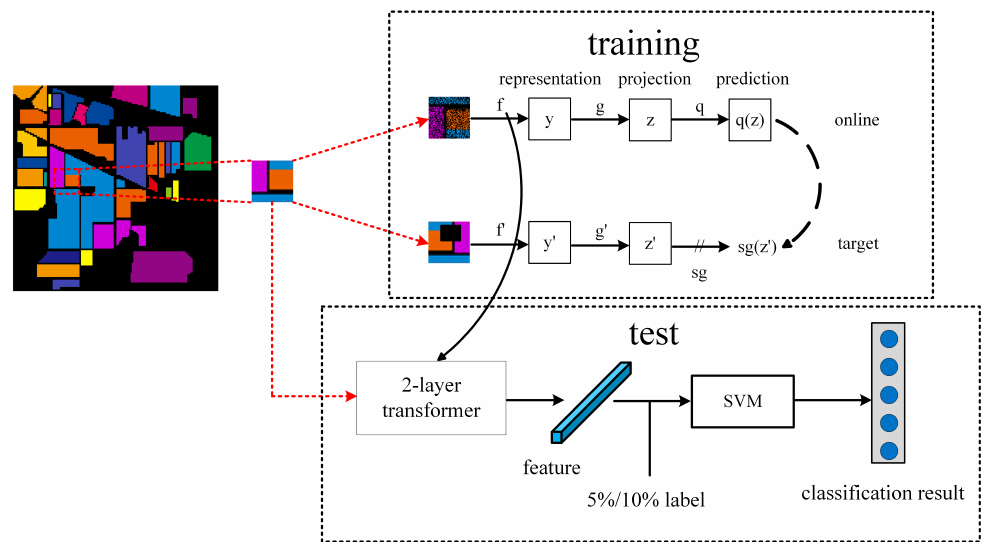
Figure 3. The overall architecture of our proposed framework.